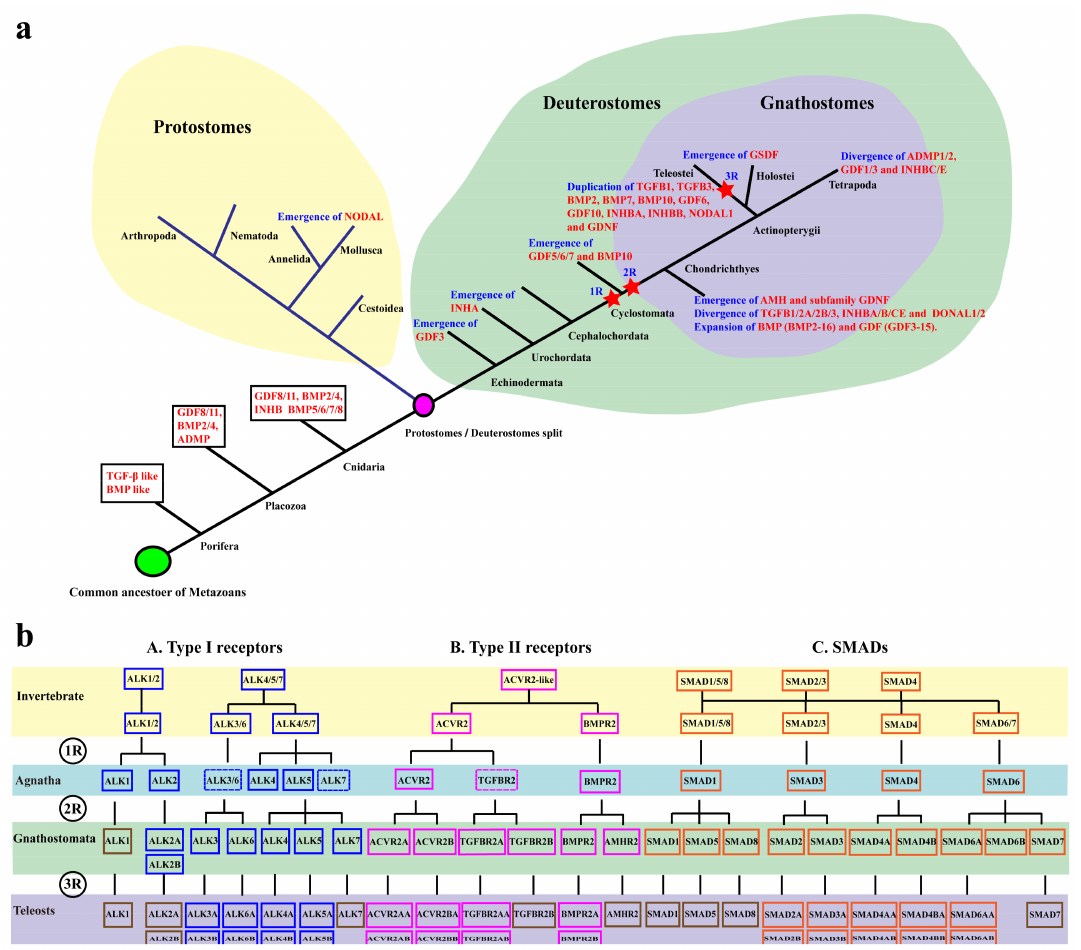
Figure 10. A schematic presentation of the evolution of TGF- β pathway members. 1R, 2R and 3R indicate the three rounds of WGD that occurred during vertebrate evolution. ( a ) Evolution of TGF- β ligands. The evolutionary tree is constructed with references from the tree of life web project (Available online: http://tolweb.org/tree/phylogeny.html). Branch lengths are not drawn to represent